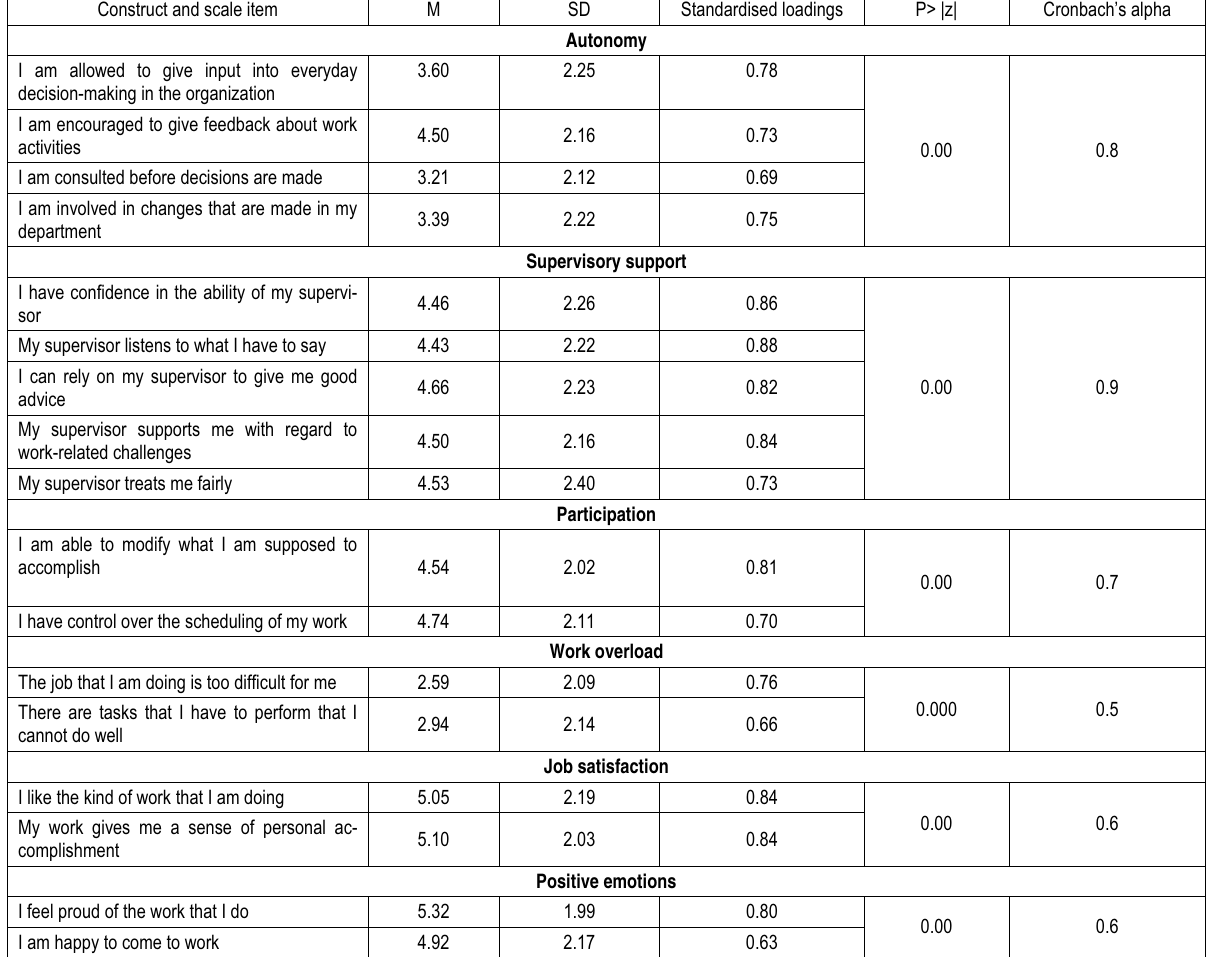
Table 2. Means, standard deviations, loadings and Cronbach’s